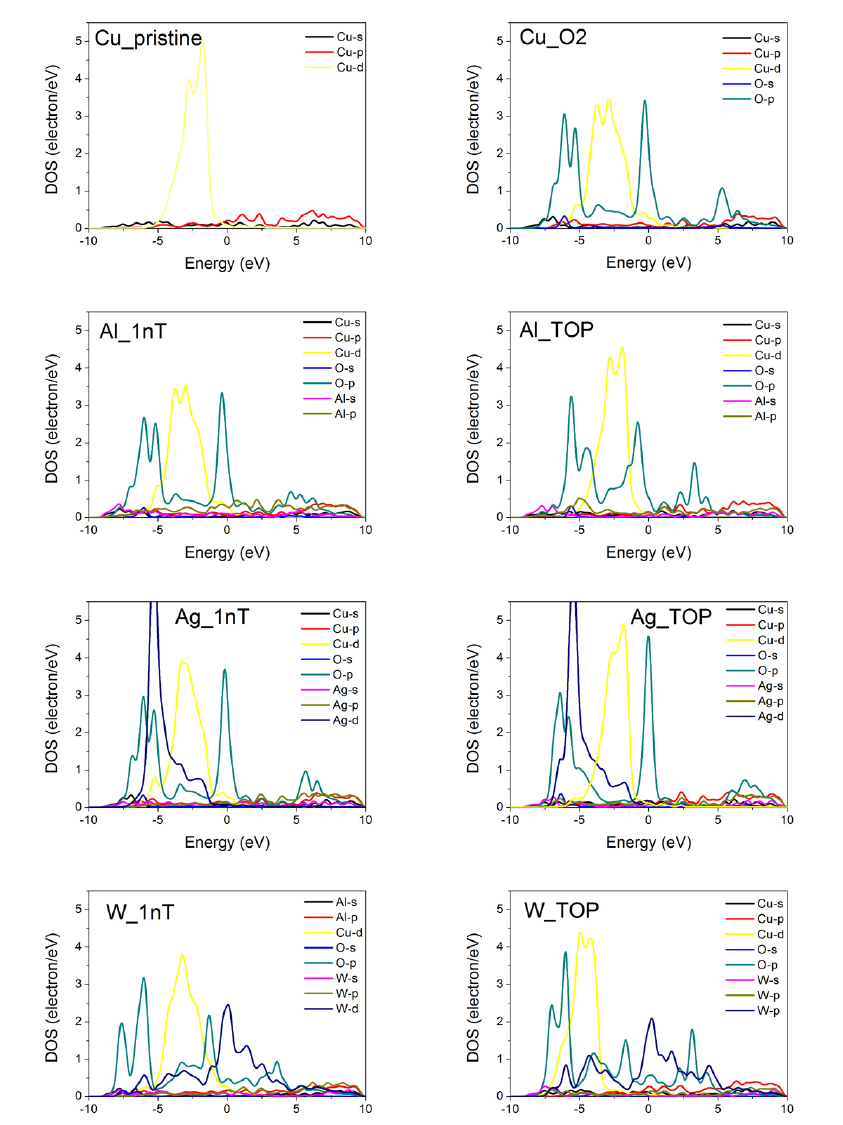
adsorbed the pristine/doped Cu 2